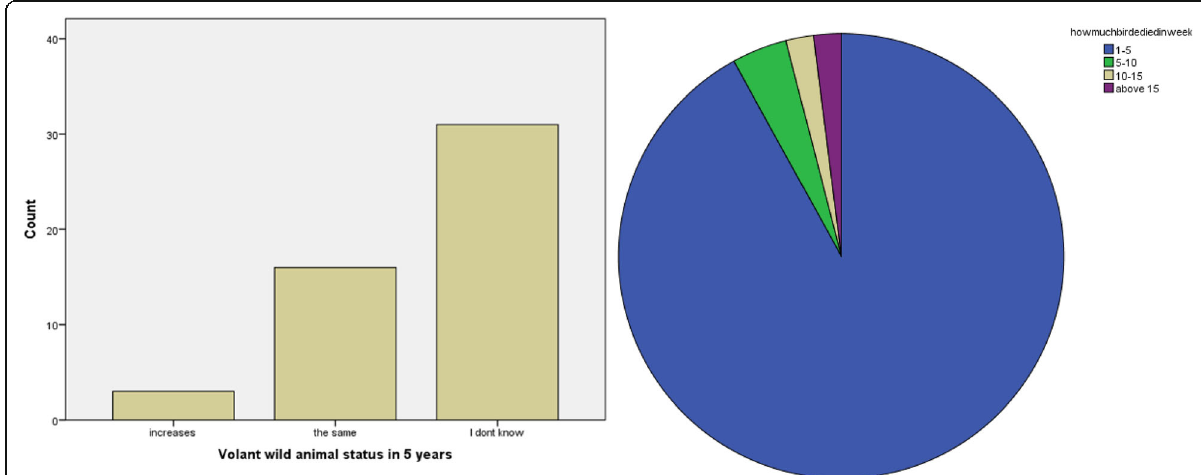
Fig. 3 Farmers ’ response in the case of how much birds die in a week due to wind farm